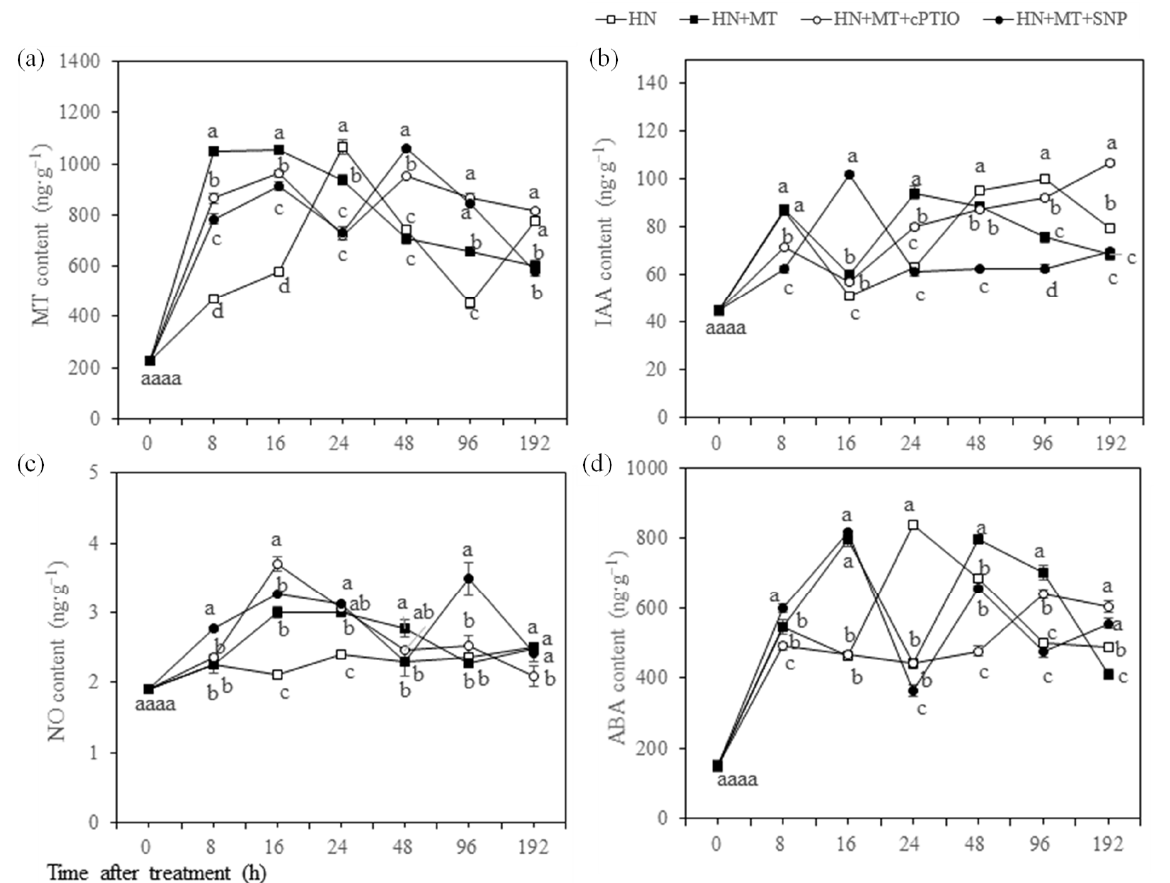
Figure 6. Effect of MT and NO on the endogenous content of MT ( a ), IAA ( b ), NO ( c ) and ABA ( d ) in the roots of cucumber seedlings under nitrate stress. Error bars represent standard deviations of the means of three independent replicates. Different letters indicate significant differences between treatments by Duncan’s multiple range test ( p < 0.05).